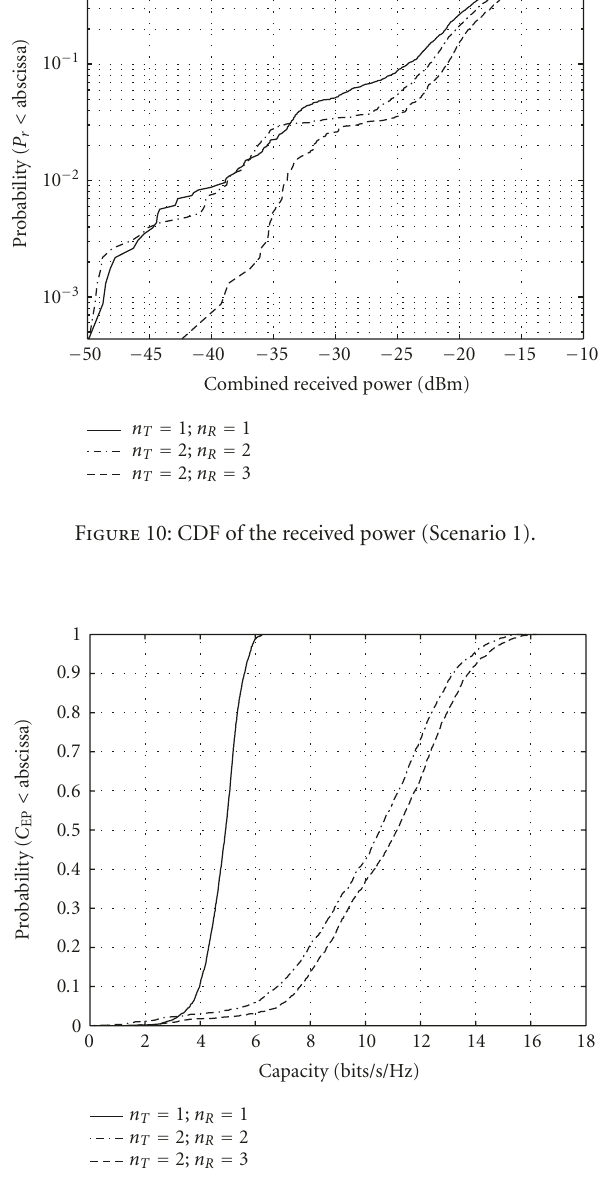
Figure 11: CDF of the equal-power capacity (Scenario 2).